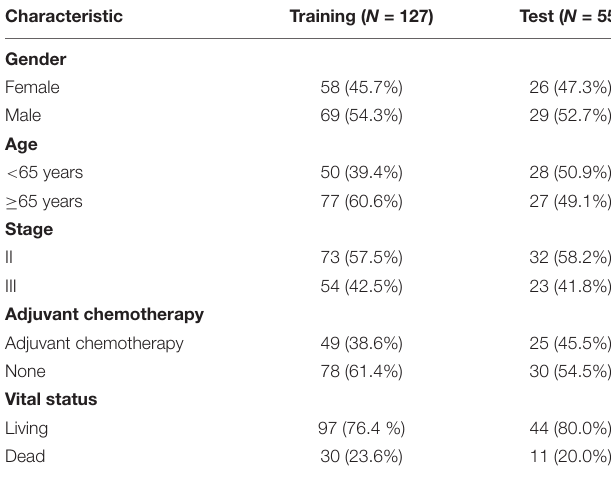
TABLE 1 | Summary of patient demographics and